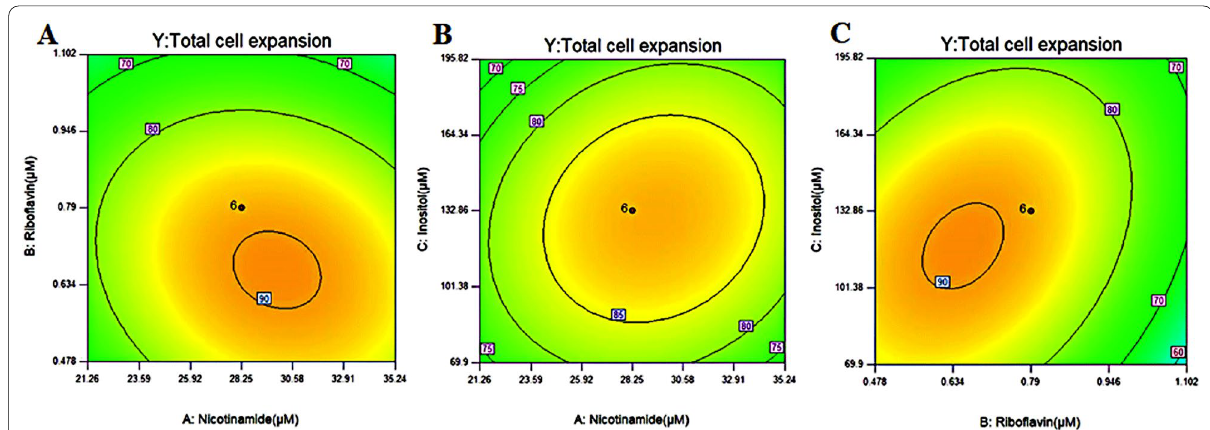
Fig. 1 Contour plots for concentration optimization of nicotinamide, riboflavin and inositol: the effect of the mutual interactions of A nicotinamide and riboflavin, B nicotinamide and inositol, and C inositol and riboflavin on NK‑92 cell expansion. ( n